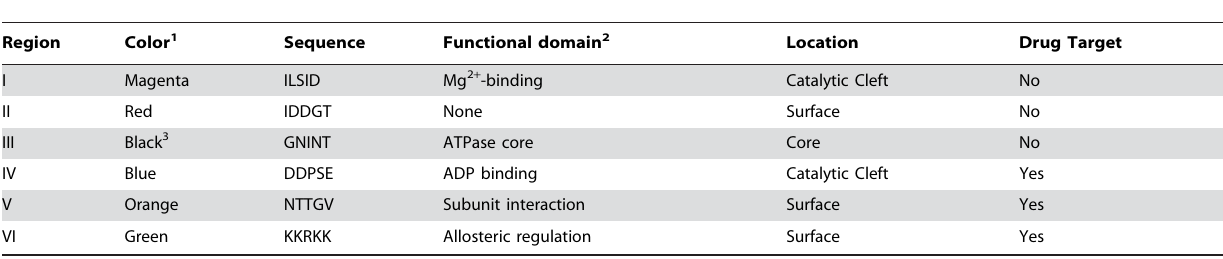
Table 2. Summary of the location and function of potential PfGK drug target